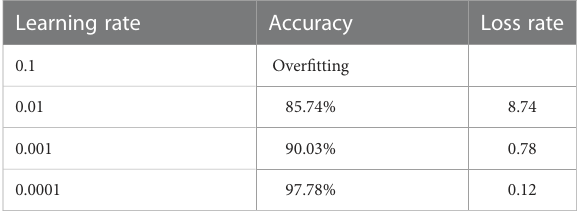
TABLE 1 Different learning